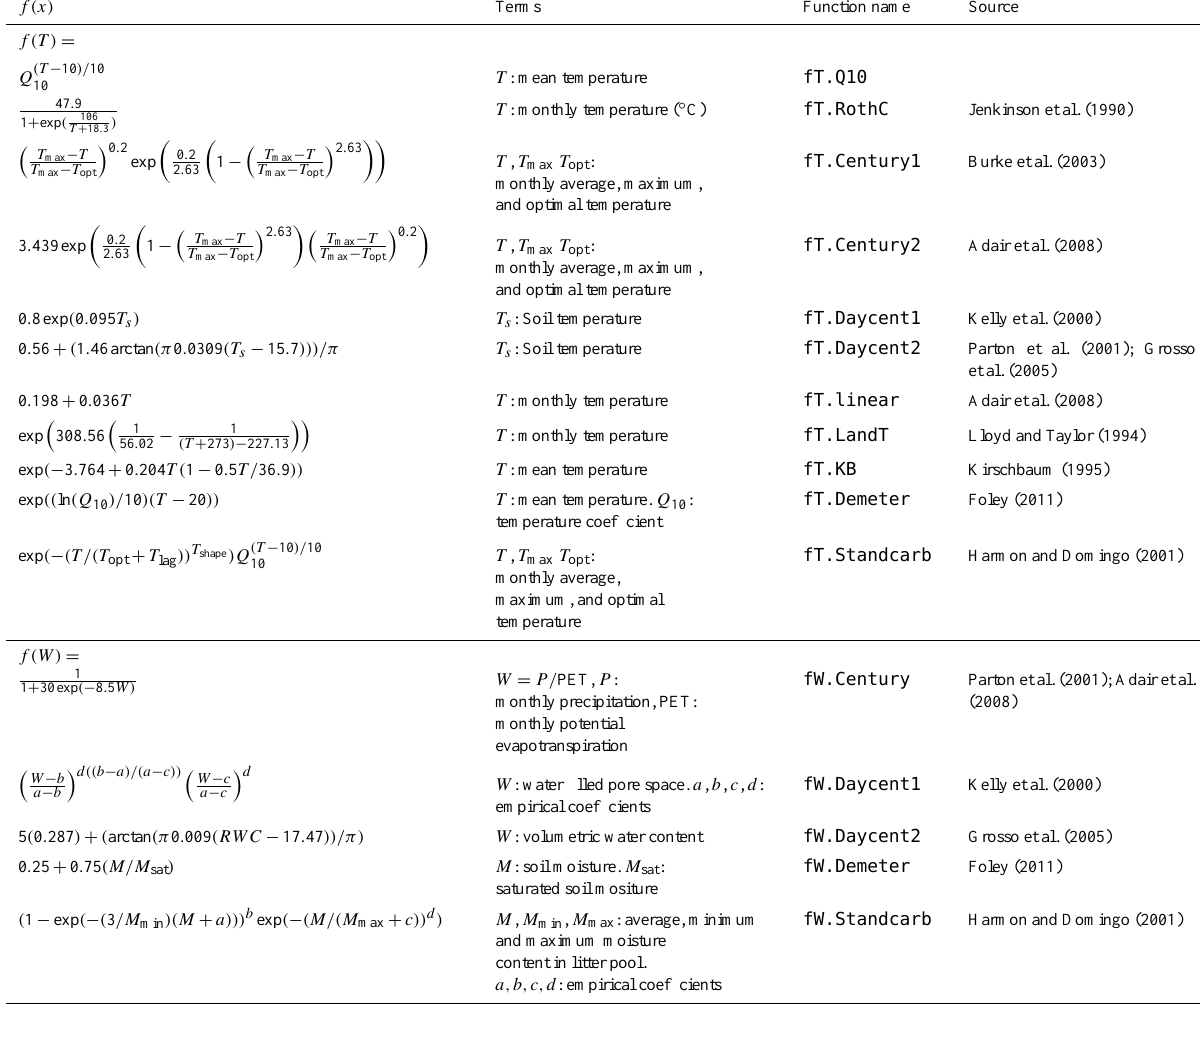
Table 1. Functions implemented in S OIL R to represent the effects of temperature T , and moisture W on decomposition